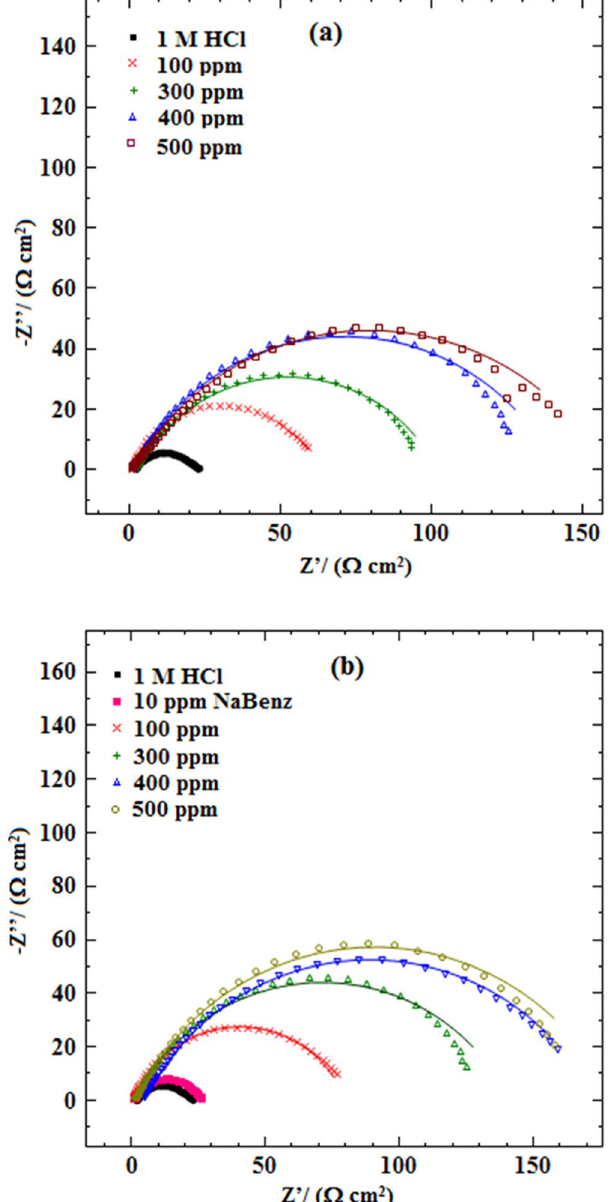
Figure 4. Nyquist plots of MS in 1M HCl solution without and with different concentrations of ( a ) LPr and ( b ) LPr + 10 ppm